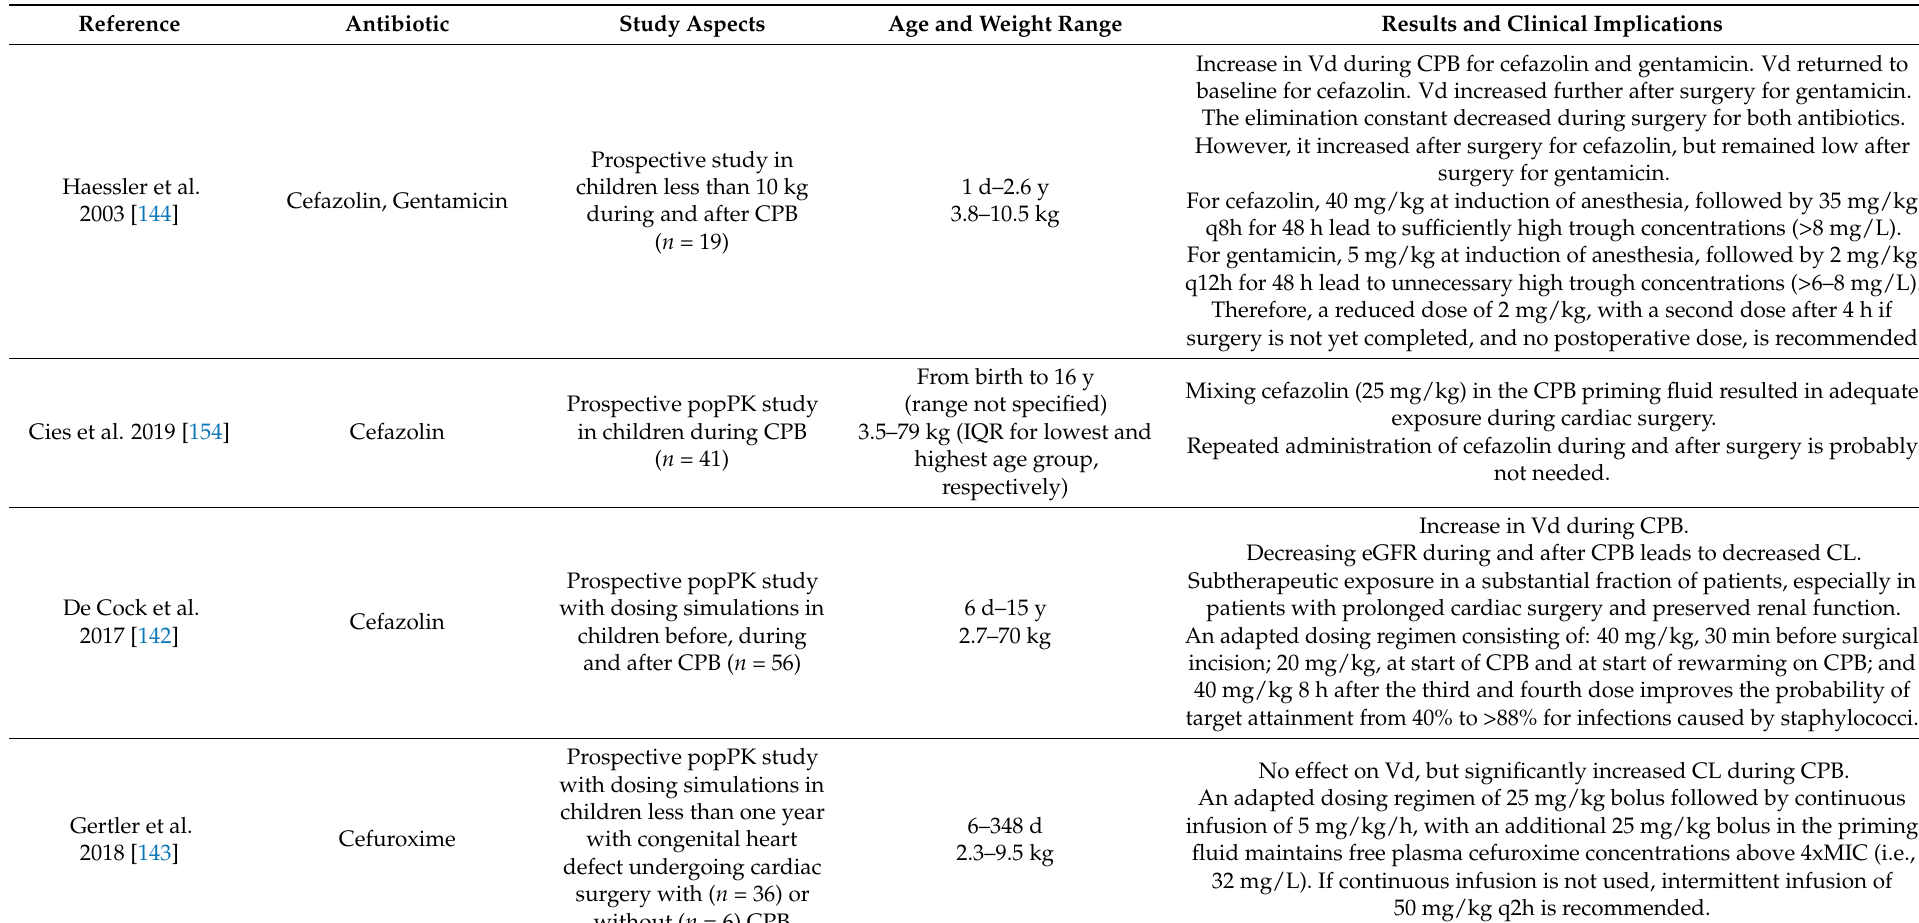
Table 6. Overview of all antibiotic PK studies performed in critically ill children and neonates supported with cardiopulmonary